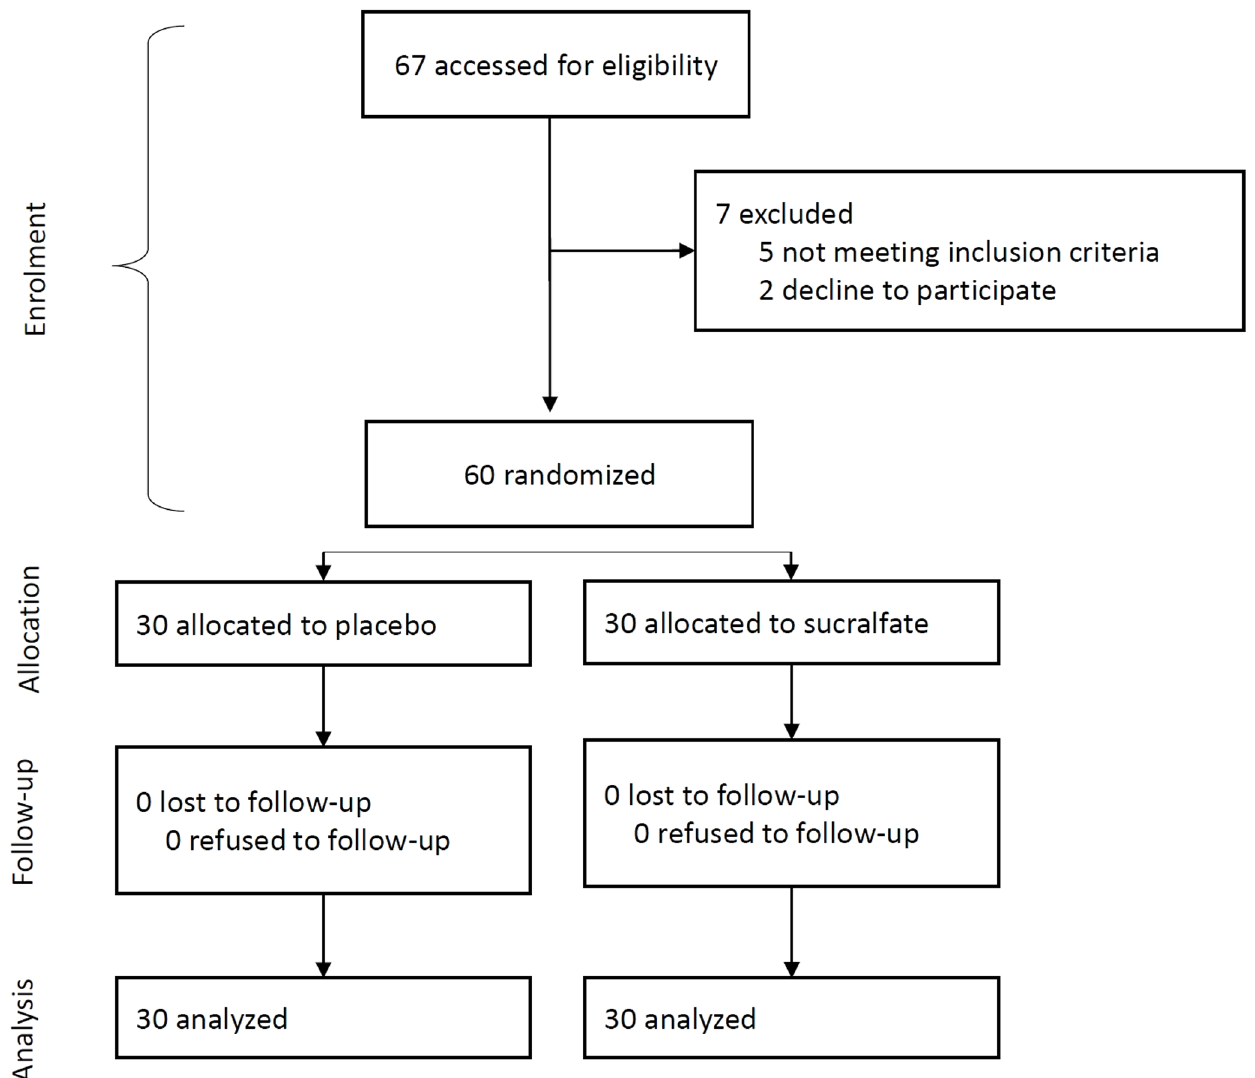
Figure 1. Flow diagram of the progress through the phases of the randomized trial of the two groups. doi:10.1371/journal.pone.0104477.g001 PLOS ONE |